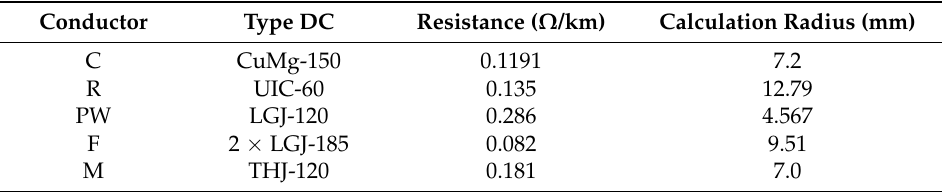
Table 3. Major parameters of traction network